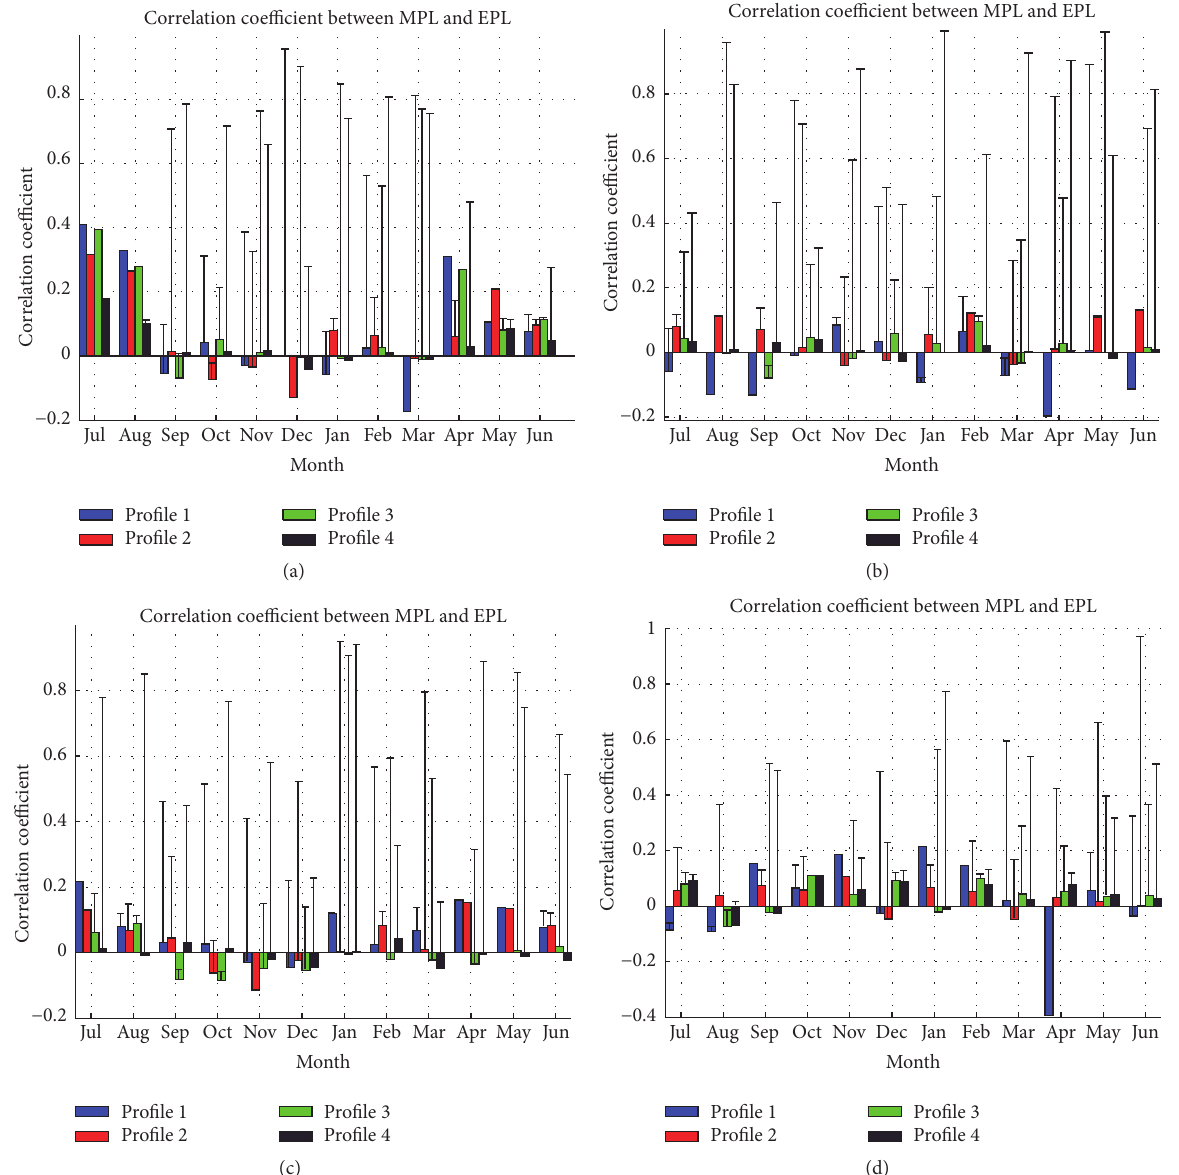
Figure 1: Monthly correlation coefficients for different 𝑀 profiles for “Link 1” in case of (a) 0 m EDH, (b) 10m EDH, (c) 20m EDH, and (d) 30m EDH. The bar and line represent the correlation coefficient and 𝑝 value, respectively. MPL and EPL are the modelled path loss and experimental path loss,